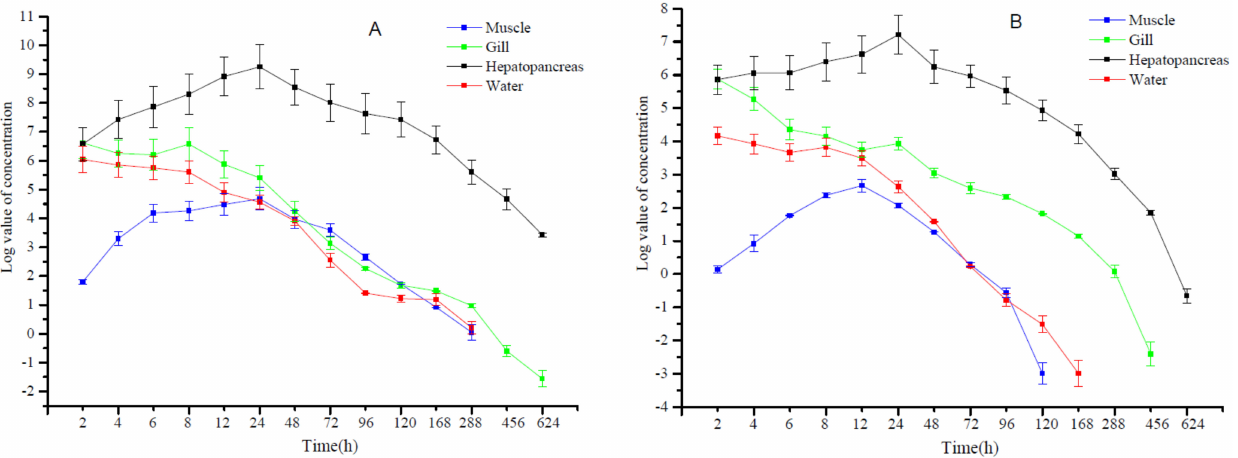
Figure 1. Log values of pendimethalin concentrations in the indicated tissues following addition to indoor tank water at ( A ) 1.6 and ( B ) 0.27 mg/L.